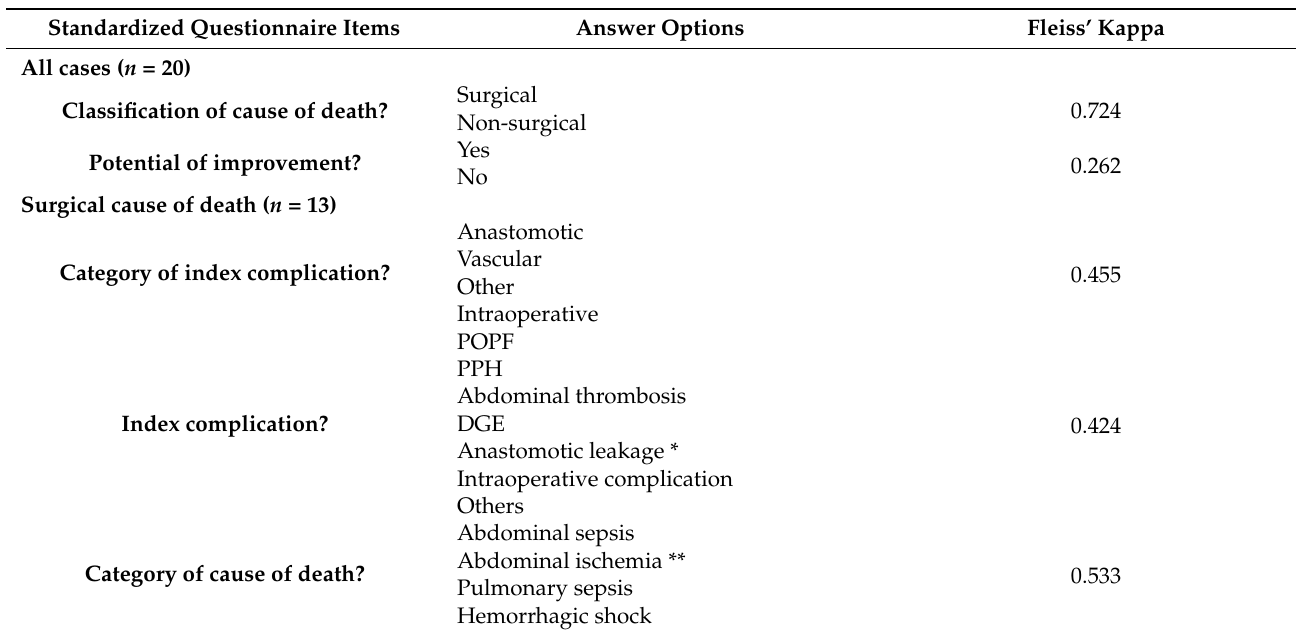
Table 7. Inter-rater reliability between participants on standardized items of the online